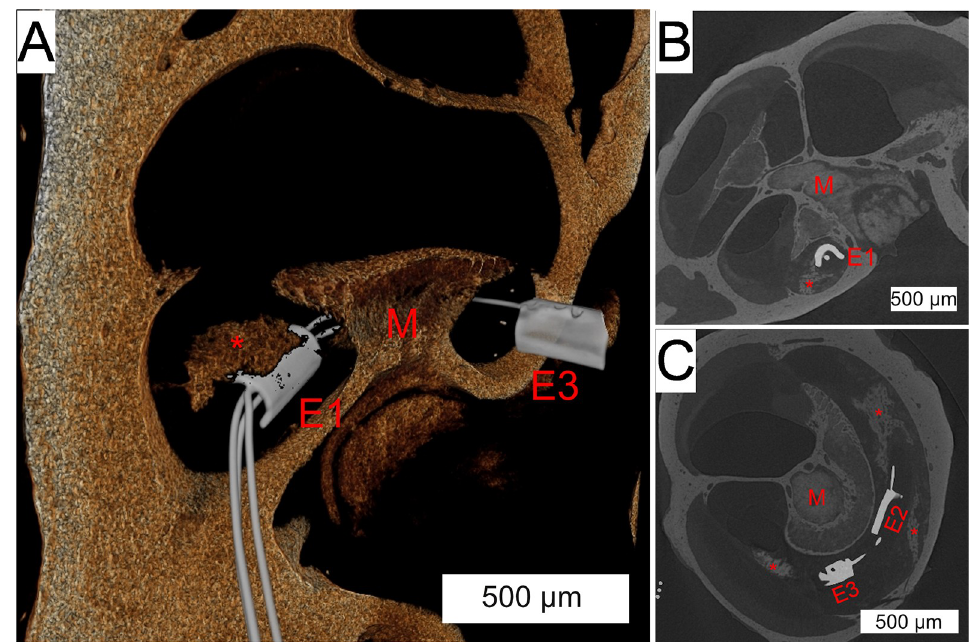
Fig 11. Co-registration of electrode array within 3D x-ray microscopic images. (A) 3D reconstruction of a 3D x-ray microscopic image shows the array trajectory through the scala tympani, around the modiolus (red “M”). The most apical electrode (red “E3”) and most basal electrode (red “E1”) are seen with a peri-modiolar orientation, with the middle electrode obscured by the modiolus. The red “ � ” denotes a foci of peri-implant neo-osteogenesis. Coronal (B) and axial (C) sections show the intrascalar orientation and trajectory of the implant with multiple areas of neo- osteogenesis (red “ � ”). The most basal (red “E1”), middle (red “E2”) and apical (red “E3”) are seen.